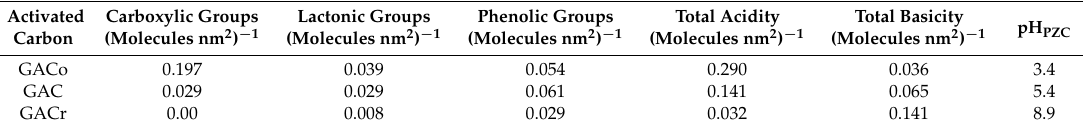
Table 2. Surface chemical groups on GAC, GACo and GACr activated